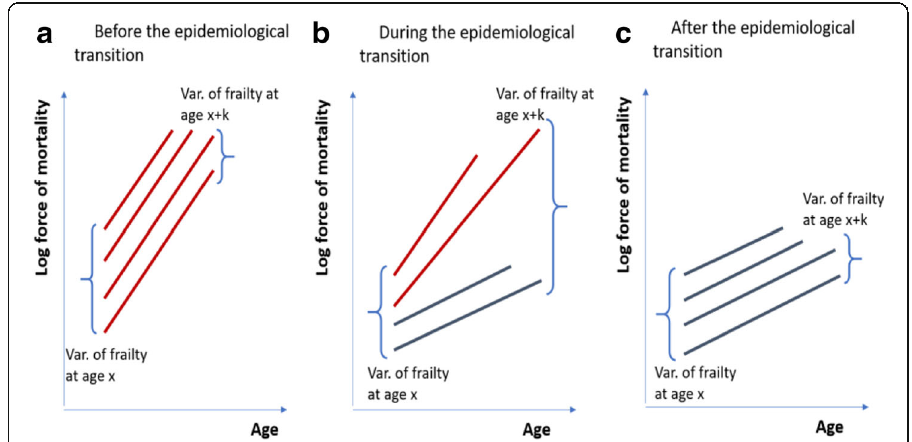
individual log hazard